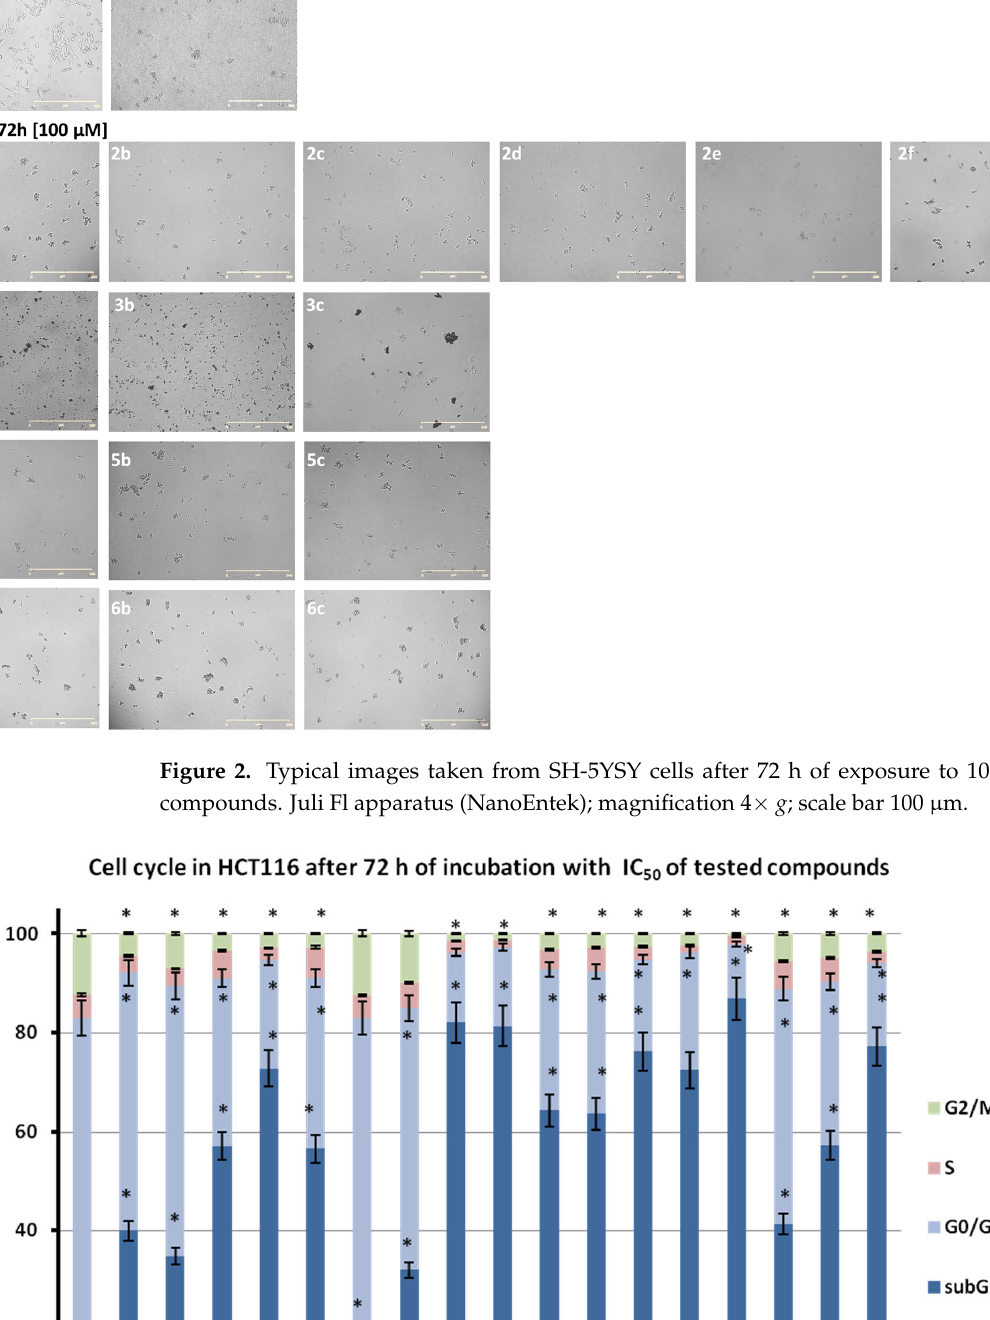
Figure 4. Cell cycle distribution in SH ‐ 5YSY cells after 72 h of incubation with doses of IC 50 or 100 μ M, respectively. SubG1 fraction represents apoptotic and dead cells. Results presented as mean from 3 experiments, +/ − SD. Statistical significance indicated by * ; evaluated by T ‐ test, where p < 0.05.